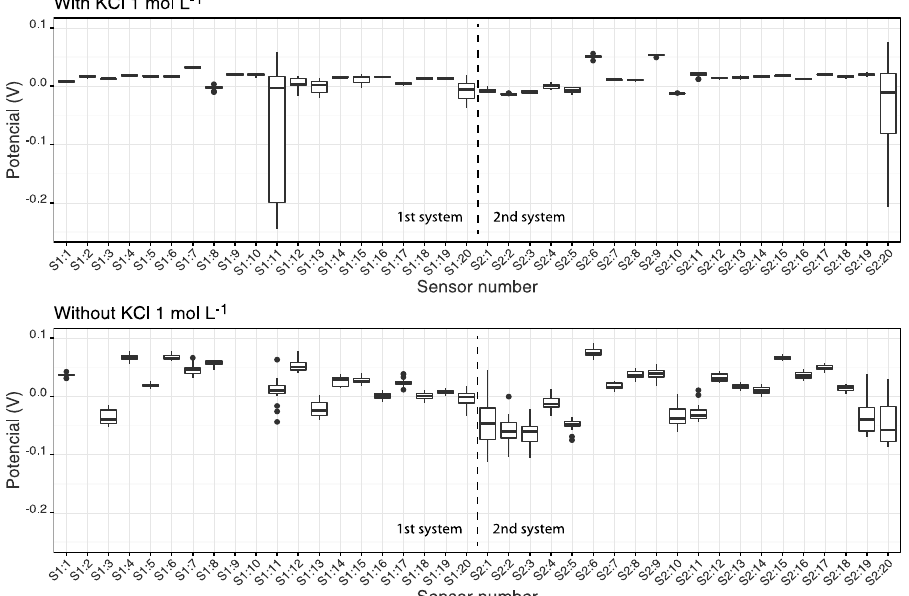
Figure 3. Extremes and quartiles of the potentiometric signals of all standard solutions with and without ionic background of KCl (1 mol L − 1 ).